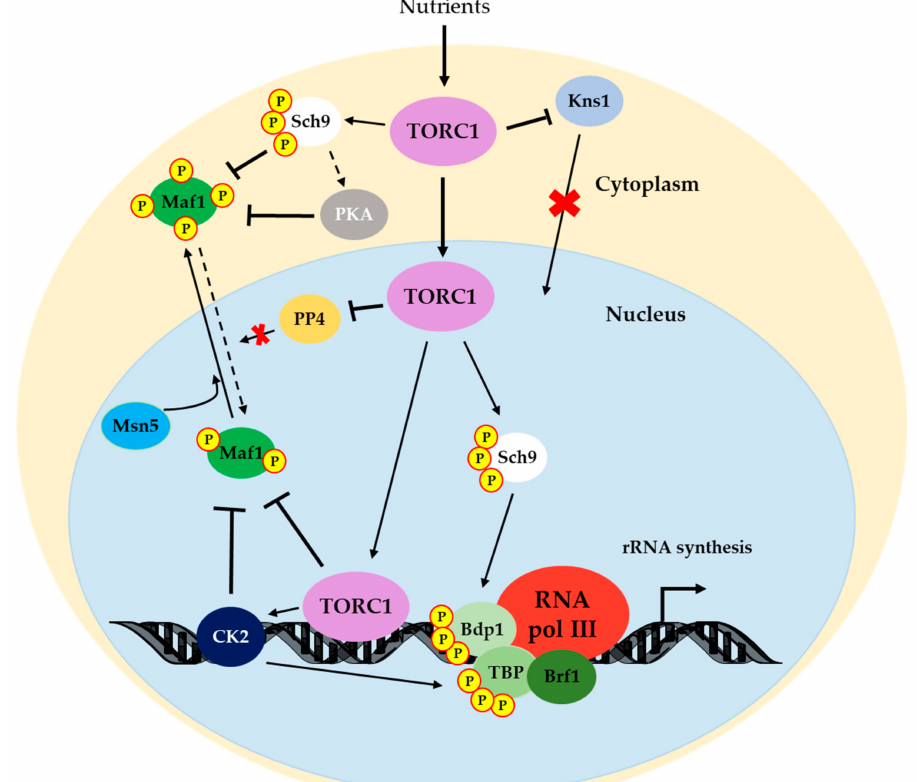
Figure 3. Regulatory network from TORC1 to RNA pol III. TOR promotes rRNA production for ribosome biogenesis by RNA pol III by phosphorylating Sch9 [28], which, in turn, maintains the Maf1 repressor in the cytoplasm through direct phosphorylation [40,107,108]. Crosstalk between TOR and the Ras/PKA pathway has been proposed, probably driven by Sch9 [120]. PKA also phosphorylates Maf1 [104,107]. TOR contributes to RNA pol III transcription by inhibiting PP4 activity over Maf1 [125] and by modulating Kns1 expression to avoid the phosphorylation of the Rpc53 subunit [128]. TOR also directly phosphorylates Maf1 in chromatin (as CK2), thus avoiding the Maf1-RNA pol III interaction [31,105]. Maf1 is then exported from the nucleus by Msn5 [103]. Additionally, Sch9 and CK2 phosphorylate Bdp1 [132] and TBP [124], respectively, to promote RNA pol III transcription. Note that the TFIIIC transcription factor is not represented since regulation by TOR has not yet been demonstrated. As in previous figures, solid lines indicate direct positive regulation. Dotted lines refer to indirect positive regulation. Bars denote negative regulation. Details for each mechanism are provided in the text. TORC1 associated with chromatin corresponds to Tor1 and Kog1